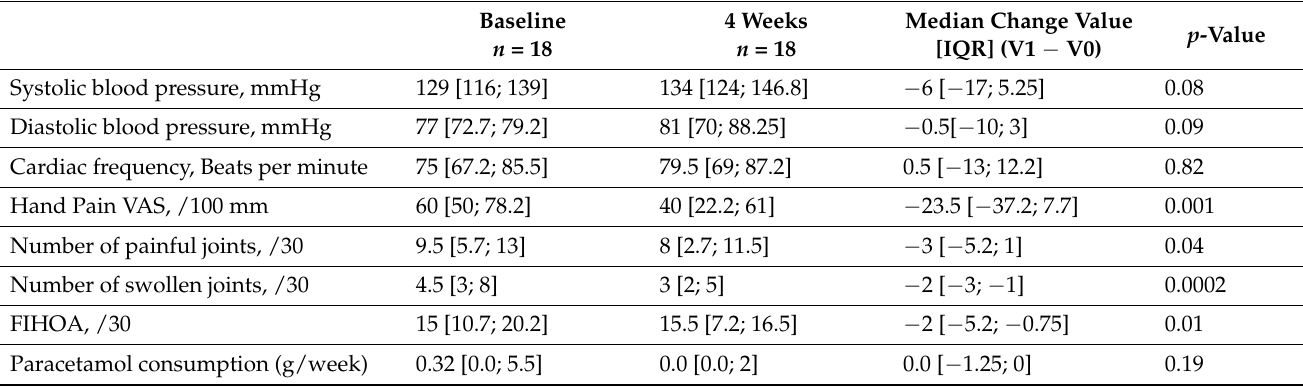
Table 3. Efficacy of 4 weeks of auricular transcutaneous vagus nerve stimulation on erosive hand OA symptoms. IQR, interquartile range. Paired, non-parametric Wilcoxon t